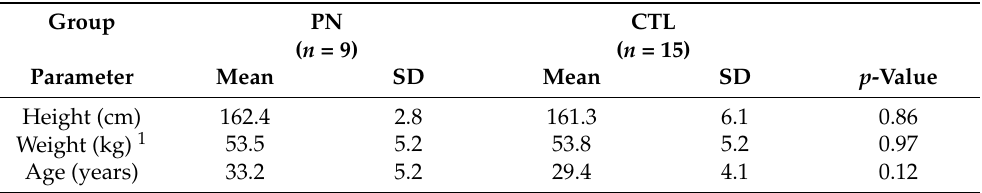
Table 1. Demographic data of perinatal and control